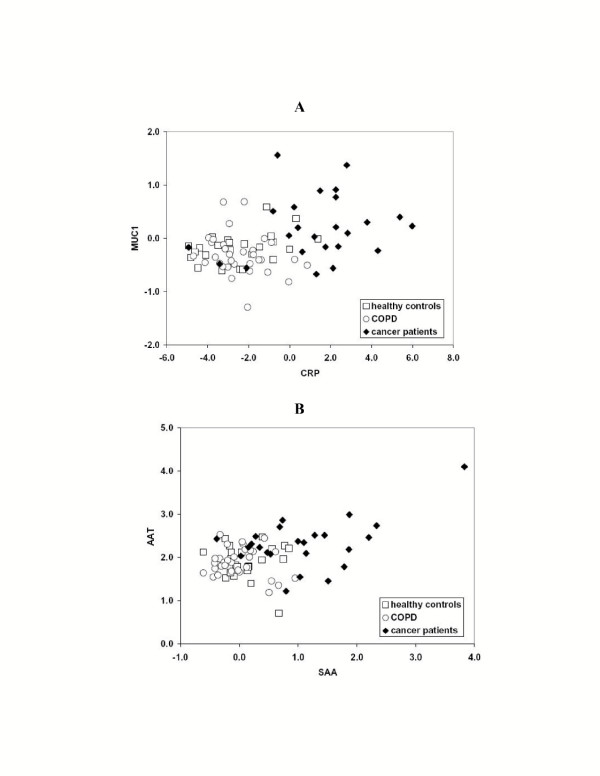
Two-dimensional plots of normalized log-base-2 ratios of sample to reference pool intensities for CRP and MUC1, and SAA and AAT.